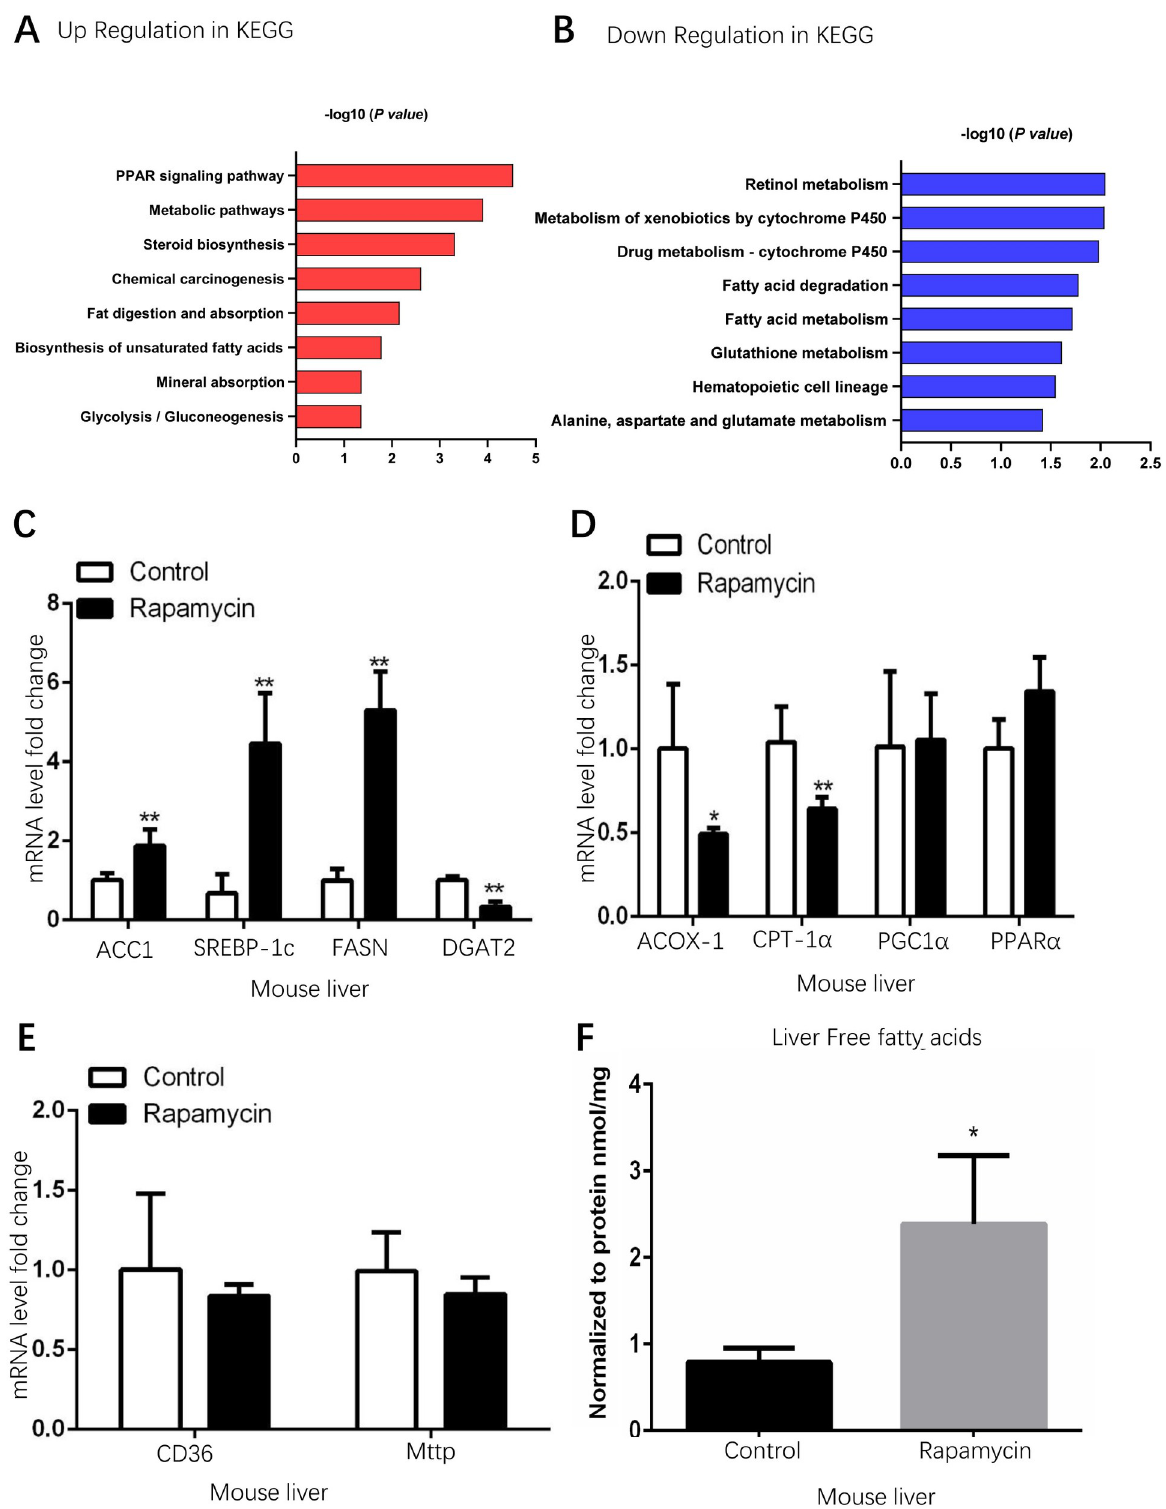
Fig 2. Rapamycin increased lipogenesis gene expressions in mouse liver. (Control group n = 7, rapamycin treated group n = 8; Data represent mean ± SD, �� p < 0.01, � p < 0.05). A & B. KEGG pathway analysis reveals that fatty acid metabolism is significantly affected by rapamycin in mouse liver. C. lipogenesis genes were significantly upregulated in the livers of rapamycin-treated mice. D. Moderate downregulation of fatty